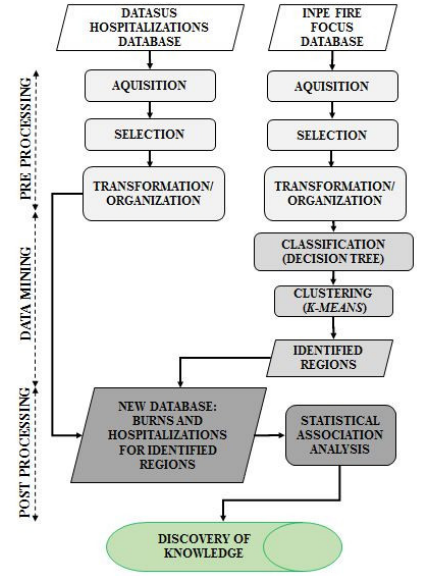
Figure 1. Flowchart of the the involved steps from pre-processing, classification (decision tree), clustering (K-means), post-processing until the knowledge discovery